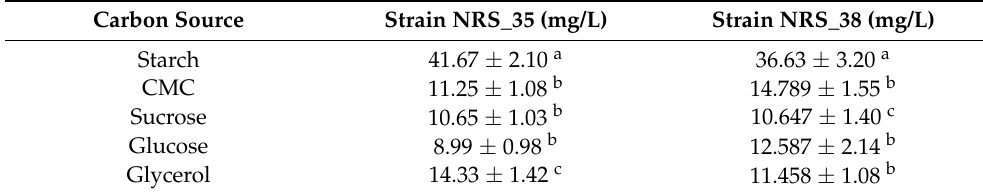
Table 2. Analysis of variance (ANOVA) of using different carbon sources on PHA